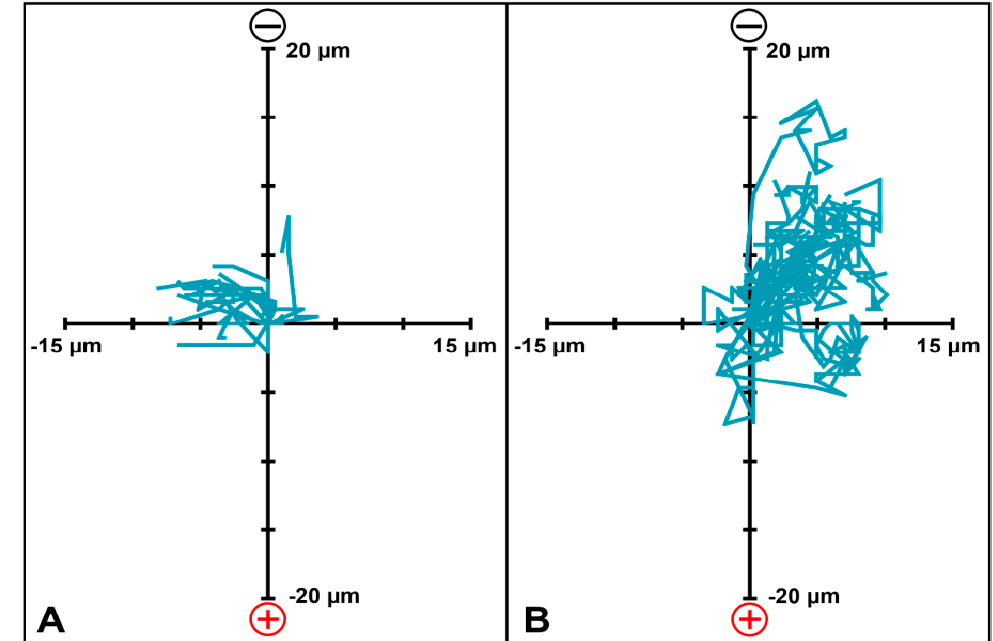
Figure 7. Individual migration paths for ( A ) CTL ( n = 20) and ( B ) EF ( n = 24) treated FLS within the 3D collagen gel. Tracking of each cell began at the origin, with positive y-displacement indicating cathodal migration.